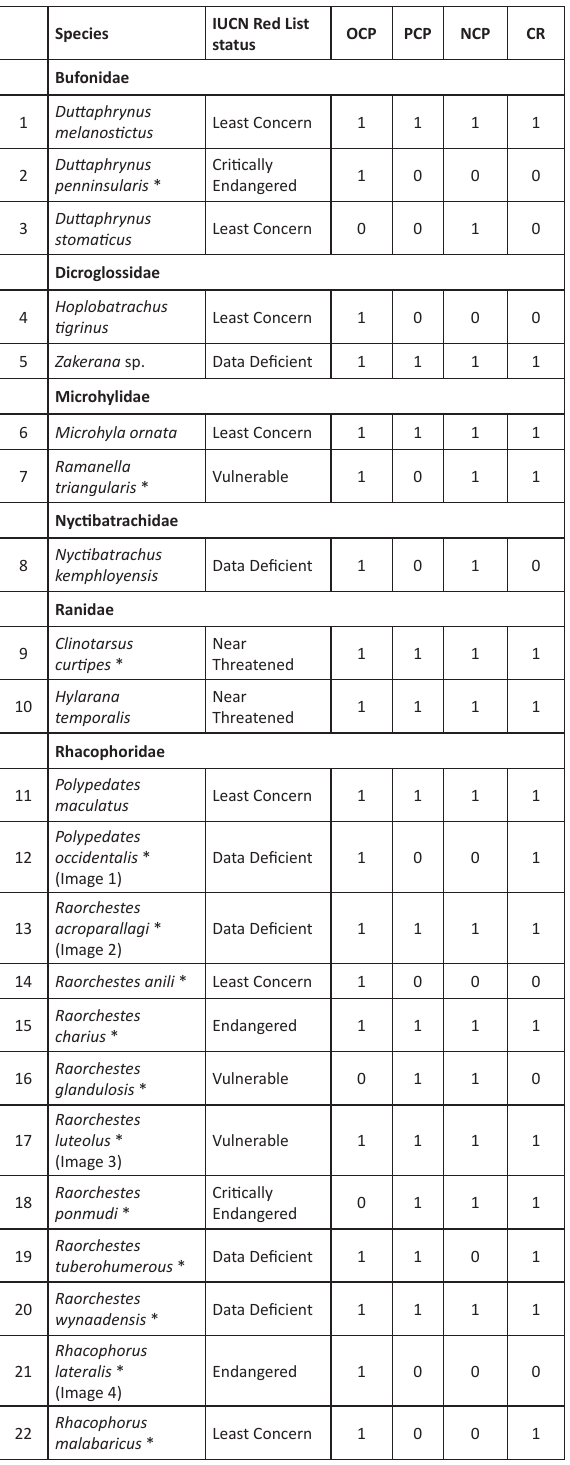
Table 3. Presence-absence data for all the recorded species across three different coffee plantation regimes and control region (Sacred